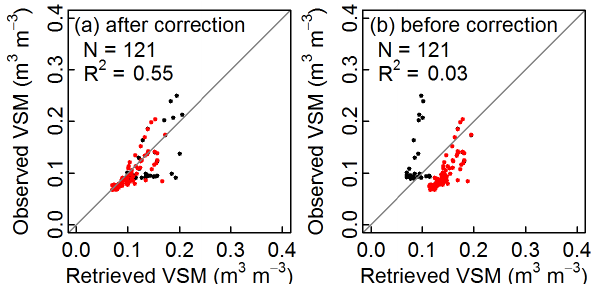
Figure 7. Scatter plots of daily mean in situ VSM observations ( N = 121) at a depth of 5cm vs. GPS L2C retrievals: (a) after vege- tation effect correction (with separate TS3 and TS4, corresponding to Fig. 6a) and (b) before correction (with merged TS3 and TS4, corresponding to Fig. 6b). The L2C SNR data acquired by the 3.3m antenna with 1s sampling interval were used. Black dots represent the retrievals ( N = 31) during TS3; red dots ( N = 90) represent the retrievals during TS4 (after grass